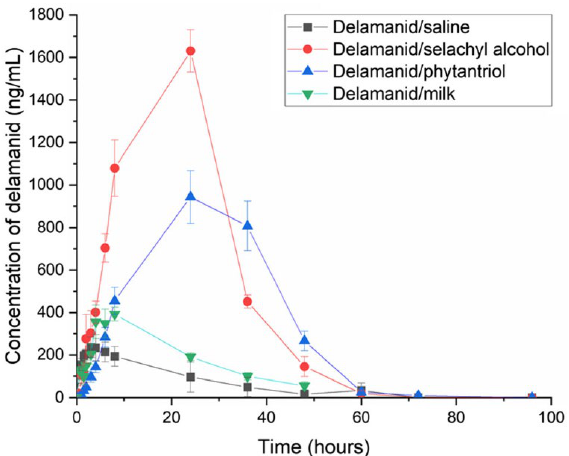
Figure 14. Concentrations of delamanid in plasma following oral administration to mice in aqueous saline suspension and through lipid-based formulations (phytantriol, selachyl alcohol and milk) over 96 h. n = 4. Adapted from reference [143], used under Creative Commons BY 4.0 license. Table 2. Overview of the publications dedicated to the encapsulation of second-line antitubercular drugs, ranked by active molecule and in chronological order. PdI: polydispersity index; drug en- capsulation: quantity of encapsulated molecule compared to the quantity of molecule used during the preparation of nanovectors, expressed as a percentage; drug loading: mass of encapsulated mol- ecule compared to the total mass of nanovectors, expressed as a percentage. Physicochemical Properties